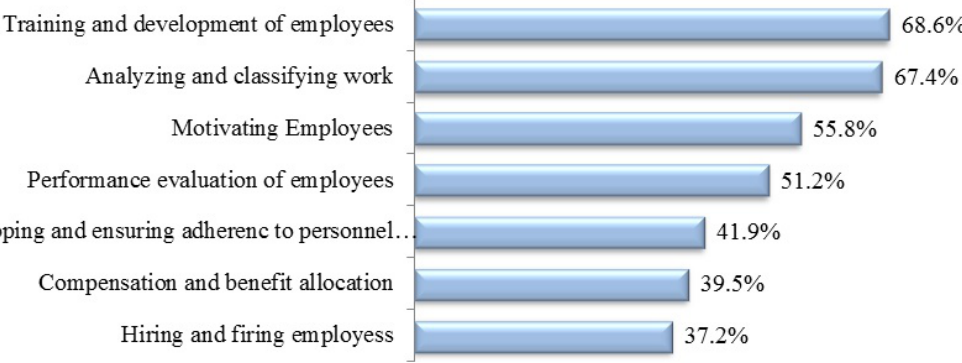
Fig. 2. Percentage of respondents who indicated that they needed help with selected HR tasks